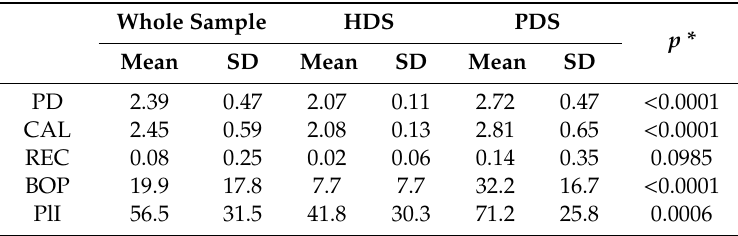
Table 2. Periodontal clinical outcome variables, for the whole sample and for the patients with Down syndrome and periodontitis or a healthy